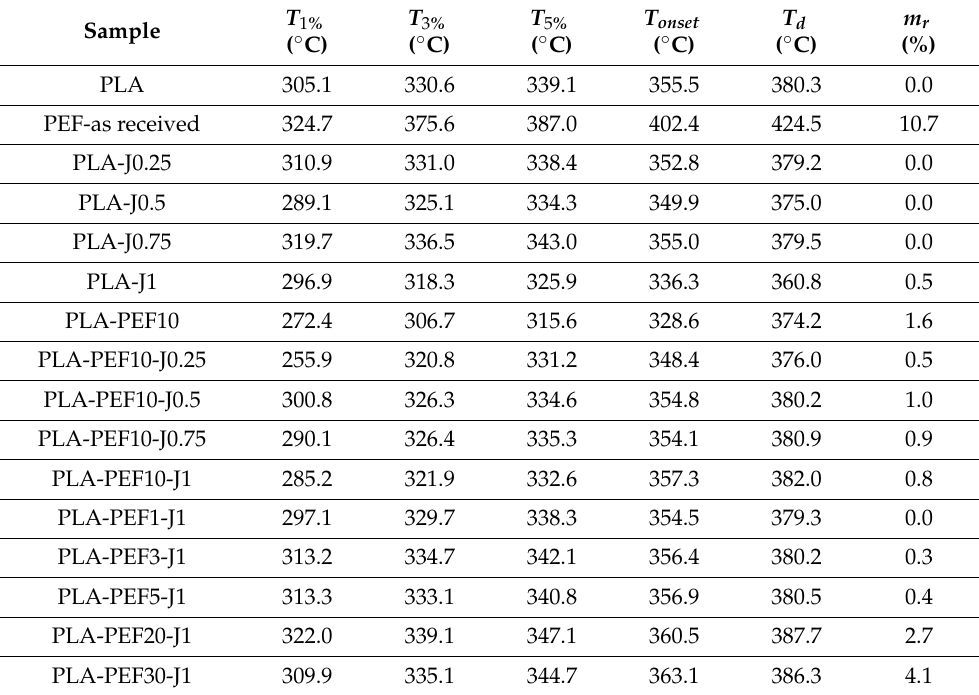
Table 3. Main results of the TGA tests on the prepared